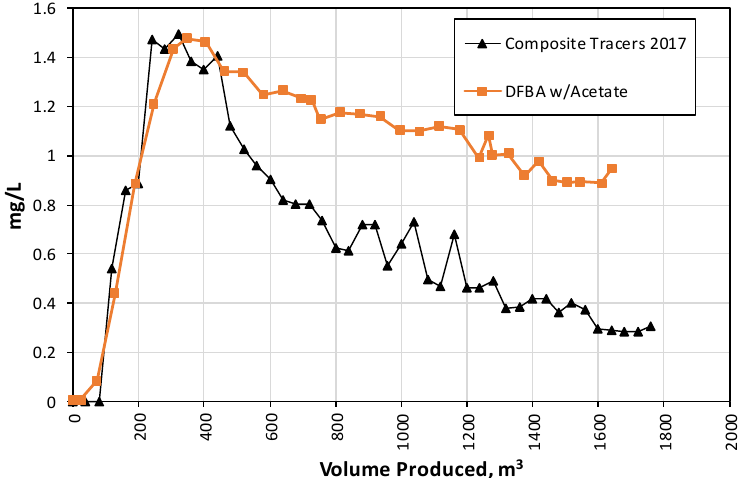
Figure A20. Breakthrough curves of tracers in well 4P-205 in fall 2017 and of difluorobenzoate after the acetate addition. Note that fall 2017 tracer concentrations are the sum of the 4 tracers arriving in 4P-205 divided by 6 (the number of injection wells used in the acetate test). The higher tail of the DFBA w/acetate curve is attributed to the recirculation of the tracer in the amendment test, whereas the tracers were diverted to a surface facility and not recirculated in the 2017 tracer test.